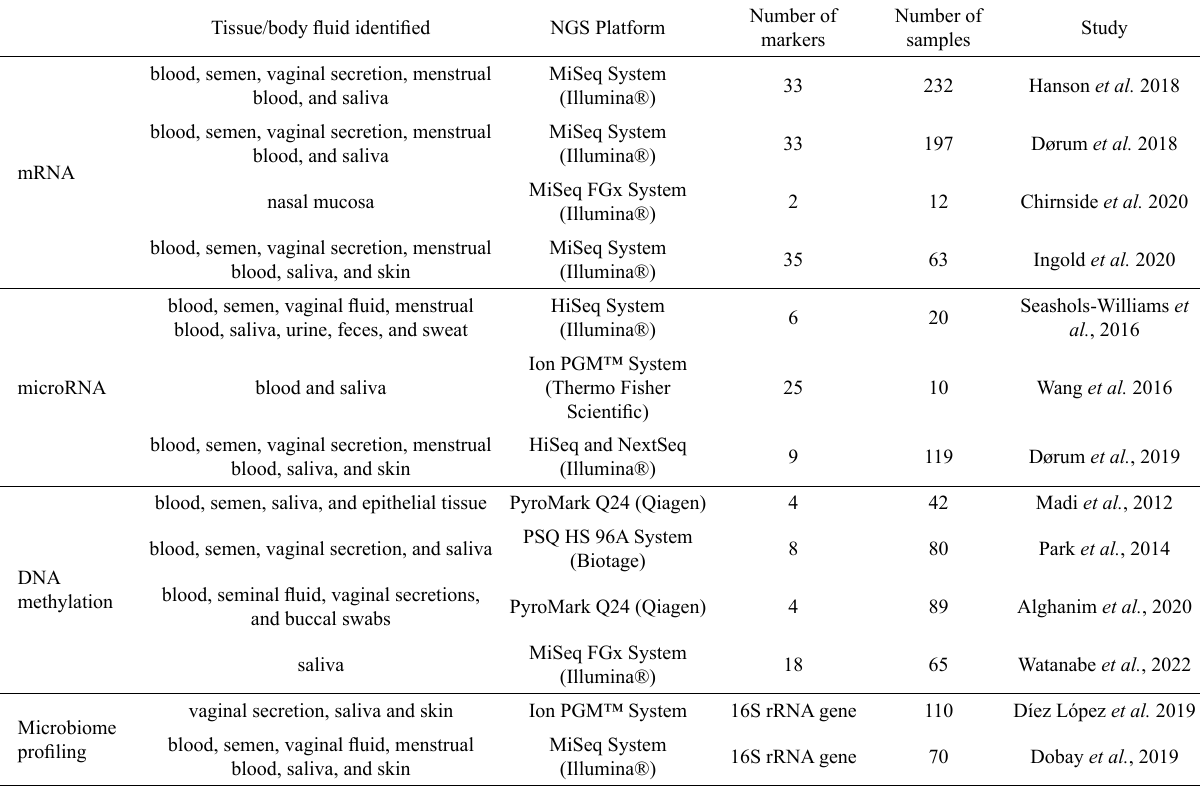
Table 2 – RNA and DNA-based technologies for fluid and tissue